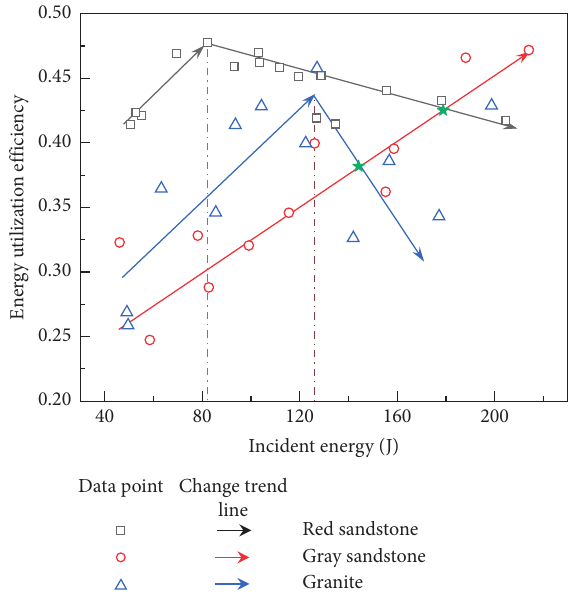
Figure 14: Energy utilization efficiency-incident energy